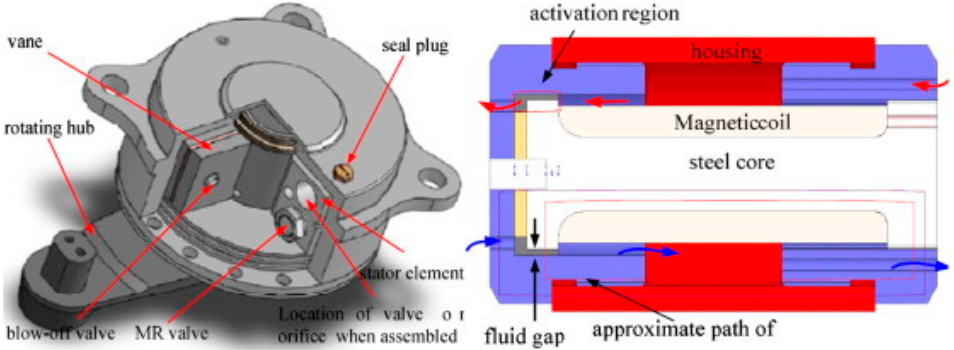
Figure 7. The structure of a MR rotary damper [79].